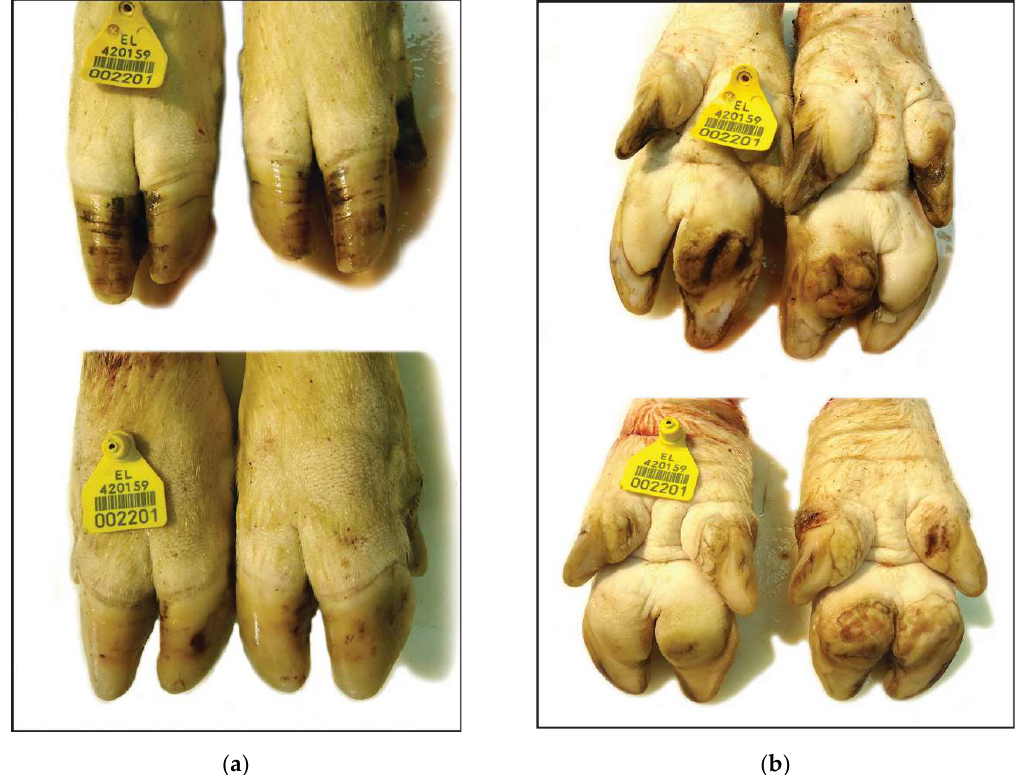
Figure 3. Claw lesions from a culled sow of genetic line C (Topigs): ( a ) Dorsal view: Normal length of the claws and few bruises and superficial cracks on an intact hoof wall; ( b ) Ventral view: Mild ulceration of the heel bulbs.